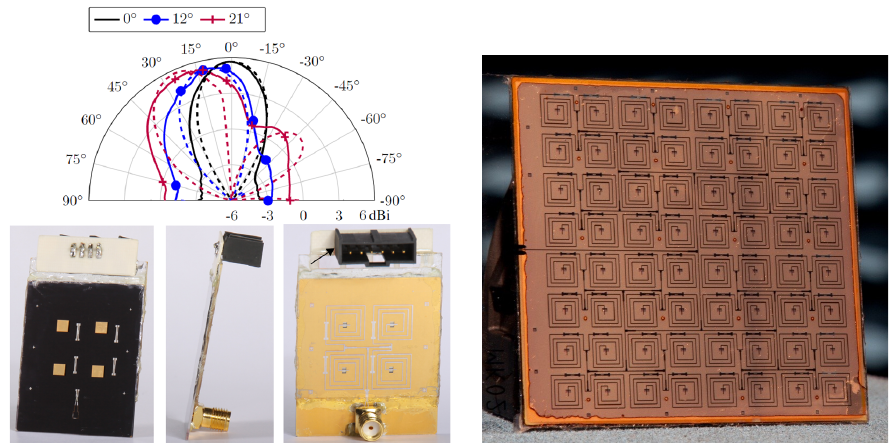
2 array × 8 sub-array realized in ×